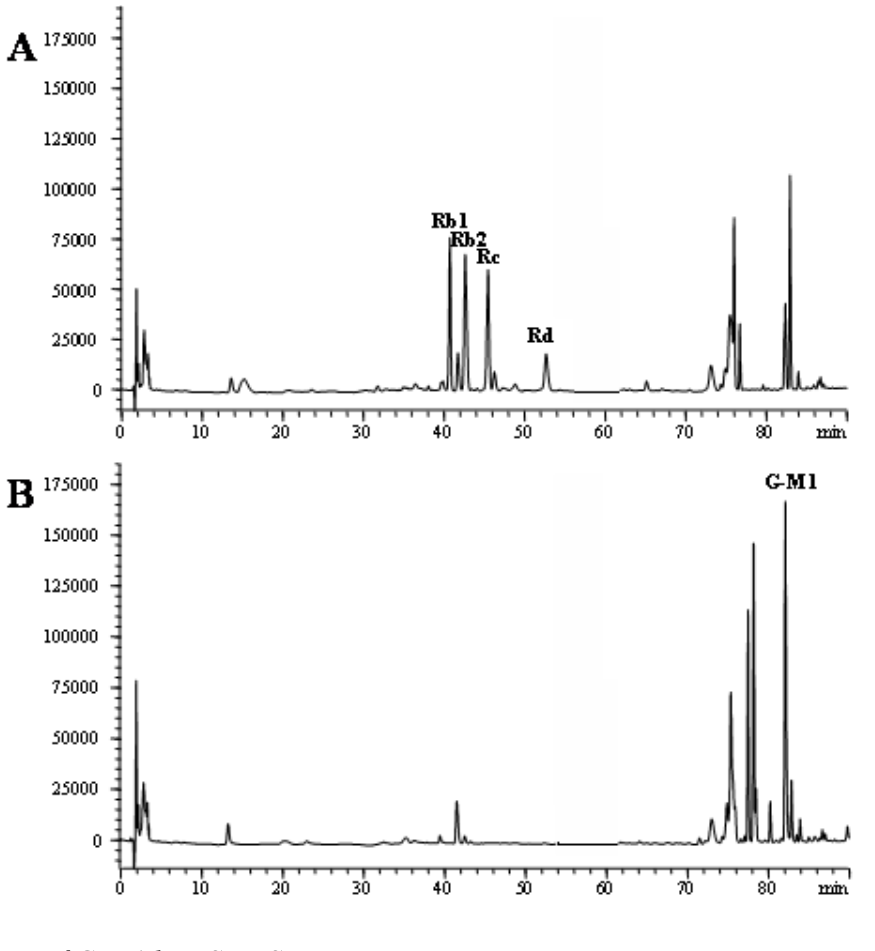
Figure 2. HPLC analysis of the bioconversion of protopanaxadiol-type ginsenosides to G-M1. Incubation time: A, 0 h, B, 24